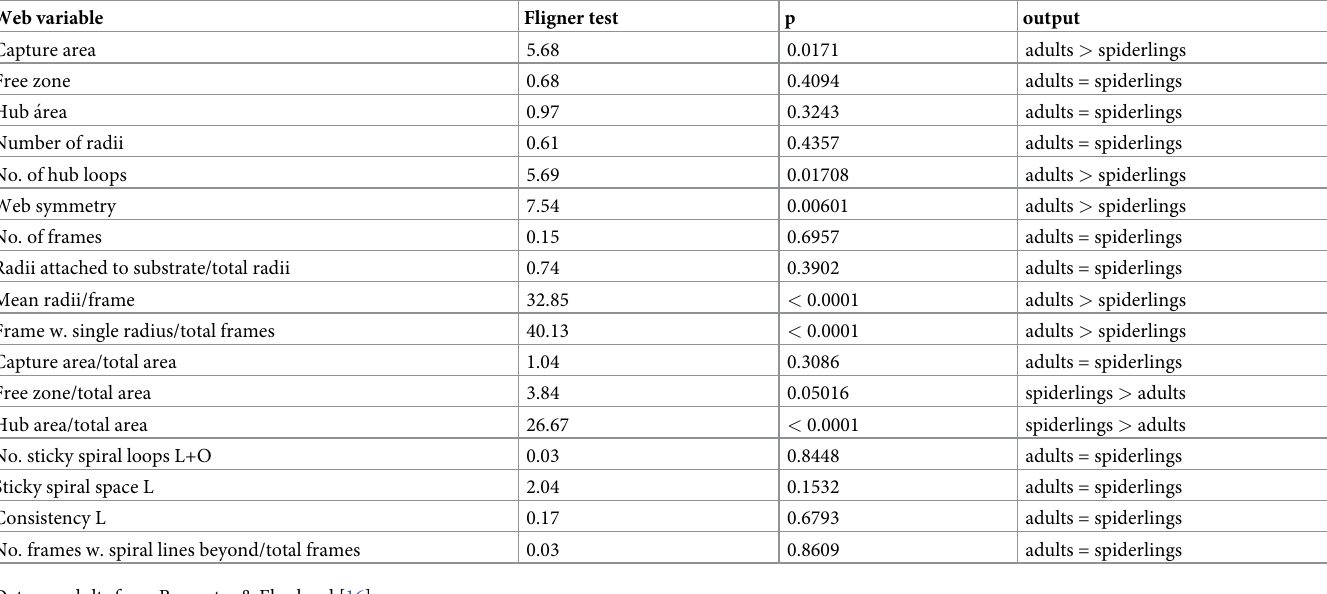
The precision of changes The variability of the residuals was similar in spiderling and adult webs in 10 of the 17 variables (Table 2). The degree of the precision of modifications in five other variables, capture area, number of hub loops, web symmetry, the mean radii per frame, the spaces between sticky spi- ral loops, and the proportion of frames with a single radius/total frames, was larger (smaller variability of residuals) in spiderlings than in adult spiders (Table 2). Spiderlings were less pre- cise in adjusting only two variables, the proportions of the web area dedicated to the free zone and to the hub (Table 2). Table 2. Statistical comparison of the variability of residuals between spiderlings and adults that were obtained from the general linear mixed models, using the Fligner test. Web